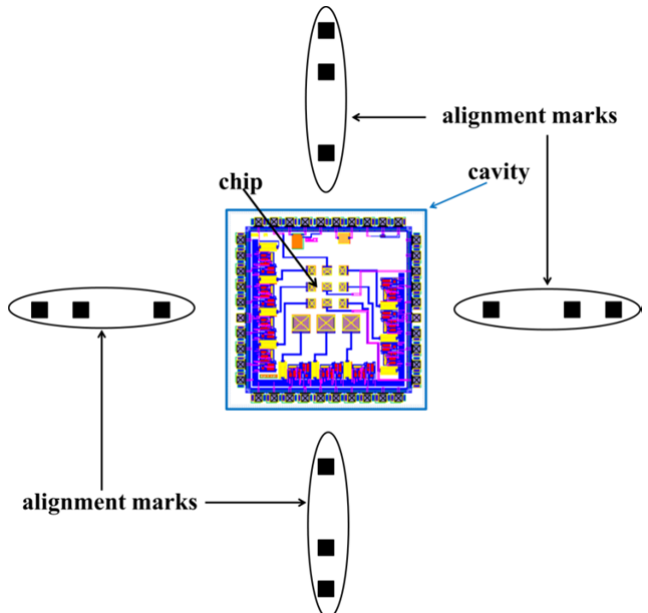
Figure 4. Layout of the mechanical frame employed for handling the CMOS